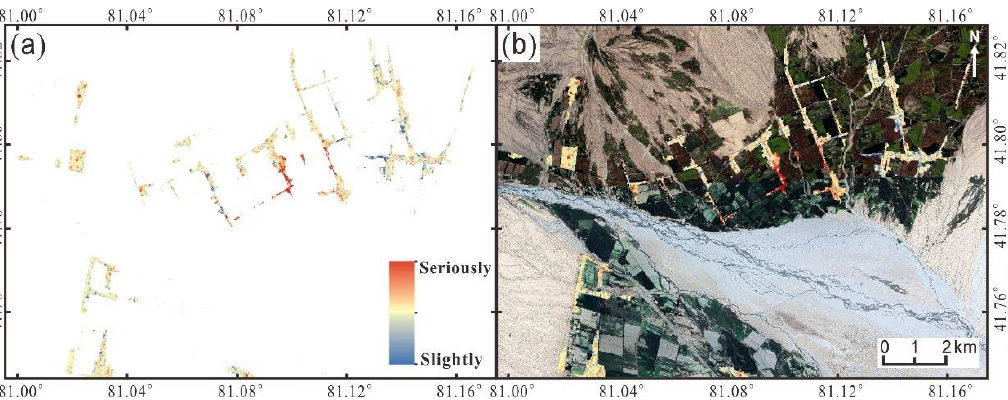
Figure 6. Coherence coefficient diagram. ( a ) Pre-seismic coherence coefficient diagram; ( b ) Coseis- mic coherence coefficient diagram . Location of the hypocenter, drawn as a black circle.